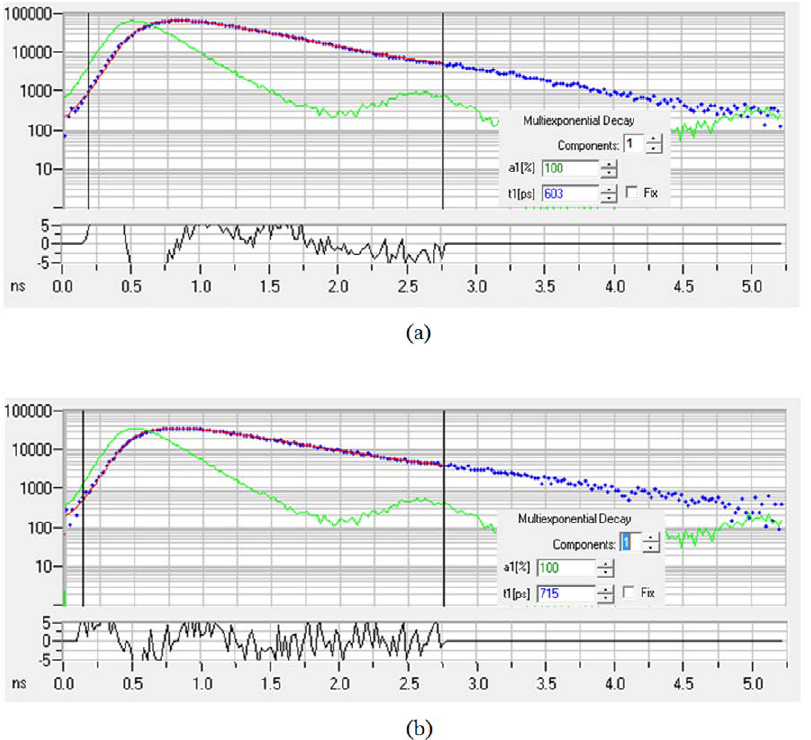
Figure 3. An example of fitting results obtained by SPCImage software, (ver. 3.2, Becker & Hickl GmbH) for measurements at the tumor (A) and contralateral (B) sites, 1 hour after injection of HER2-specific Affibody conjugated to Dylight750 in a mouse with high HER2 expressing human tumor model (BT-474). X axis is the amplitude and y axis is the measurement time (ns). Blue and green graphs show the measurement data and impulse response function of the system, respectively. The fitting was based on single exponential decay model. Parameter a1 shows the relative of amplitude in single exponential decay model and t1 is the lifetime (in picoseconds). The small graph at the bottom is the fitting error and the red line shows the fitted curve.